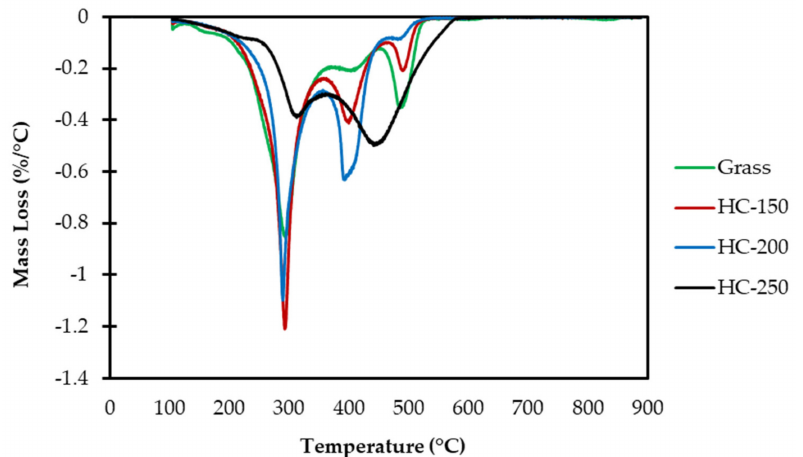
Figure 3. Derivative thermogravimetric (DTG) burning profiles of grass and hydrochars. Data is reported on a dry-ash-free